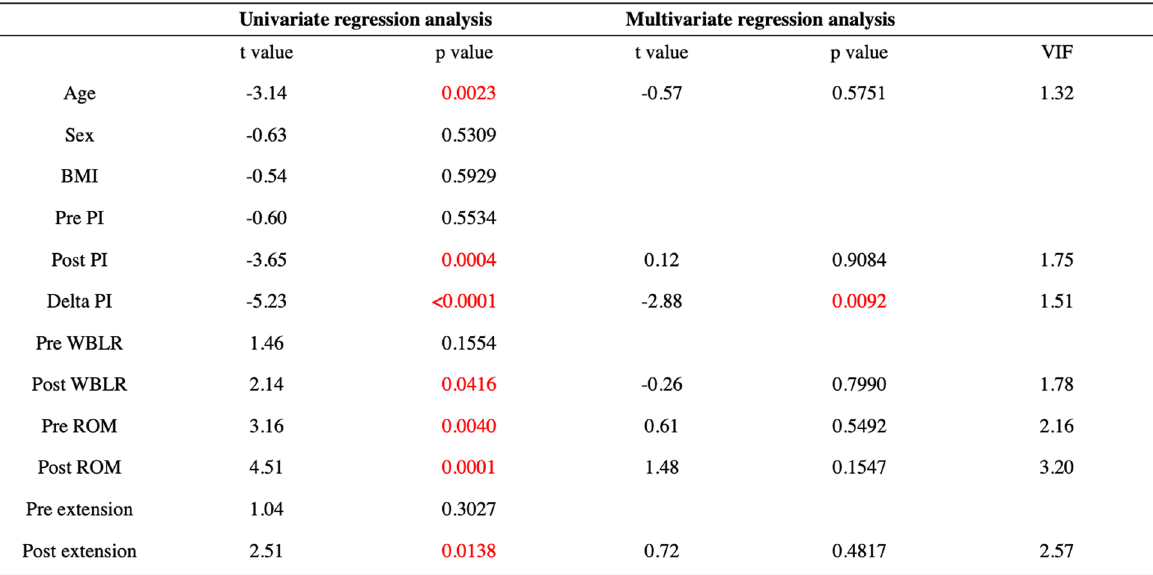
Table 4 Regression analyses of the factors affecting the improvement of clinical